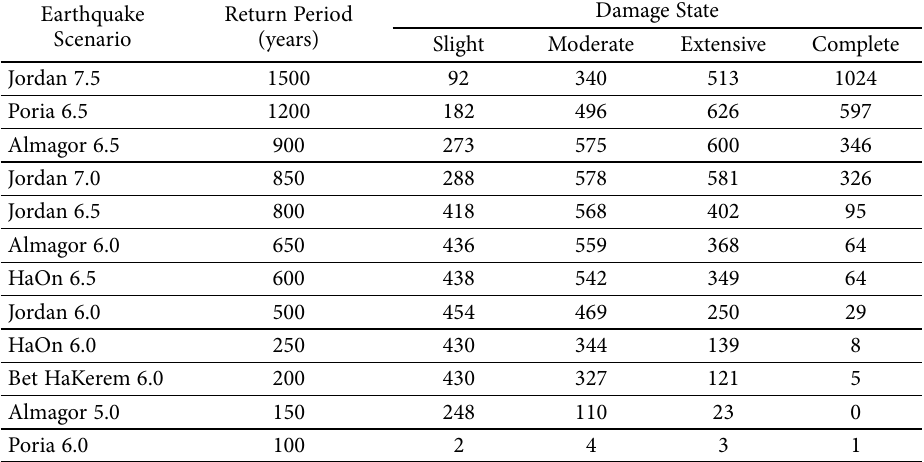
Table 2. Number of buildings damaged in historical earthquakes